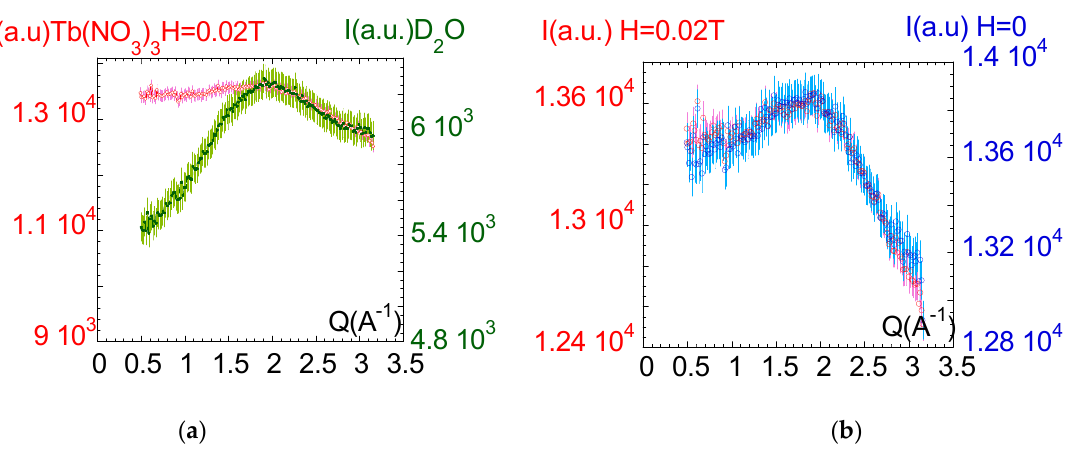
Figure 4. ( a ): Wide-angle neutron diffraction (Barotron G43, λ = 2.34 Å, ∆λ / λ ≅ 1%, d = 0.05 m). Heavy paramagnetic atoms are strong radiation absorbers, as the comparison between the D 2 O scattering and the deuterated solution of Tb(NO 3 ) 3 0.1 M shows. Red points correspond to the paramagnetic solution. Green points correspond to the deuterated water scattering (first peak of the structure factor) and serve as a reference. The error bar is estimated at 5% of the coherent signal. ( b ): Wide-angle neutron diffraction (Barotron [38], λ = 2.34 Å, d = 0.05 m). Comparison of the scattering curves of the first peak of the structure factor of the deuterated solution of Tb(NO 3 ) 3 0.1 M with and without magnetic field. The sample is placed in homogeneous magnetic field oriented perpendicular to the incident beam. Blue points correspond to the scattering without magnetic field while red points correspond to the scattering when the magnetic field was applied (0.02T delivered by an electromagnet). The error bar is estimated at 5% of the coherent signal.